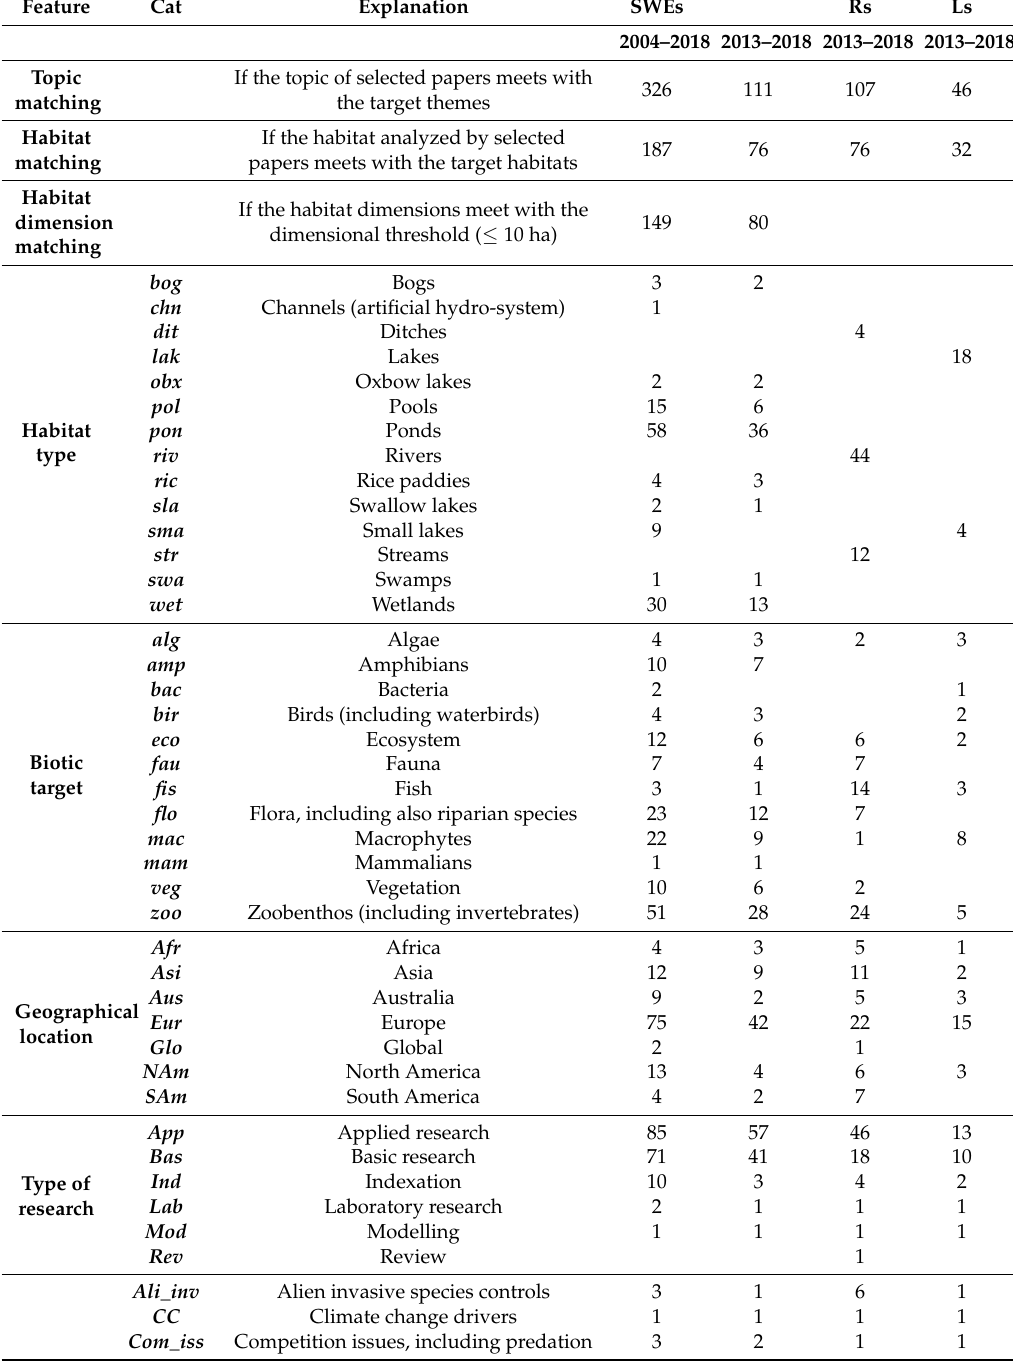
Table 1. List of features and categories used in the evaluation matrix performed for the inspection of selected literature, and their representativeness across target ecosystems (SWEs = small standing-water ecosystems, Rs = rivers, and Ls = Lakes), and publication periods (2004–2018 for SWEs, and 2013–2018 for SWEs, Rs, and